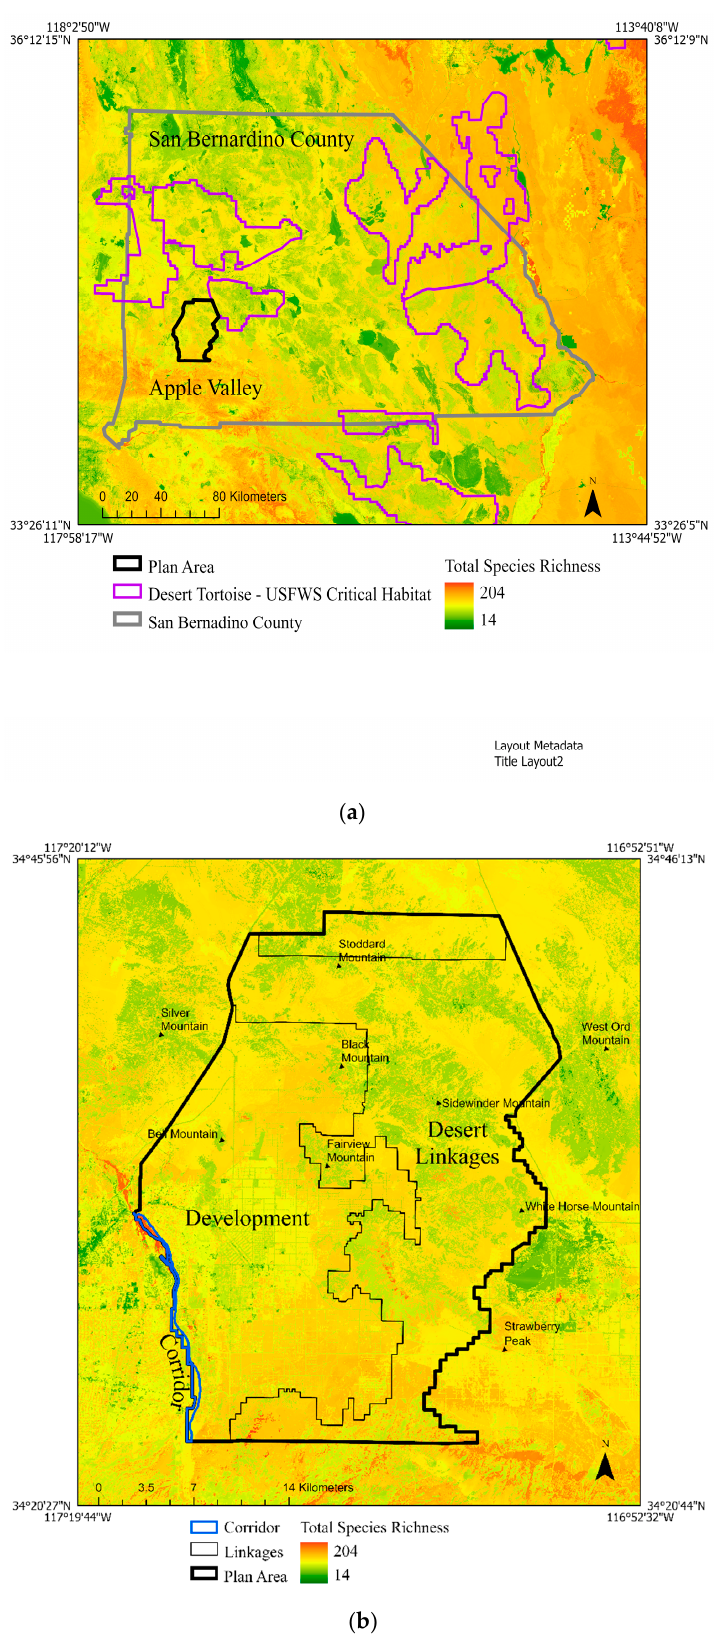
Figure 2. Total Vertebrate Species Richness within ( a ) San Bernardino County and ( b ) the Apple Valley Multi-Species Habitat Conservation Development zone, Linkages, and Mojave River Corridor.